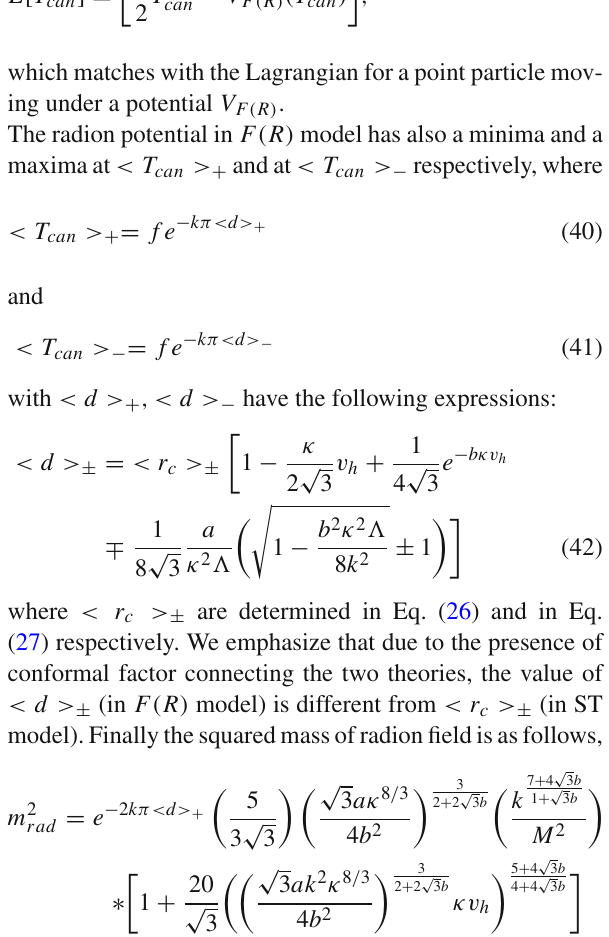
Fig. 4 P F ( R ) vs b for a = 1 , k = M = 1 ,(cid:11) = − 1 ,κv h = 0 . 01